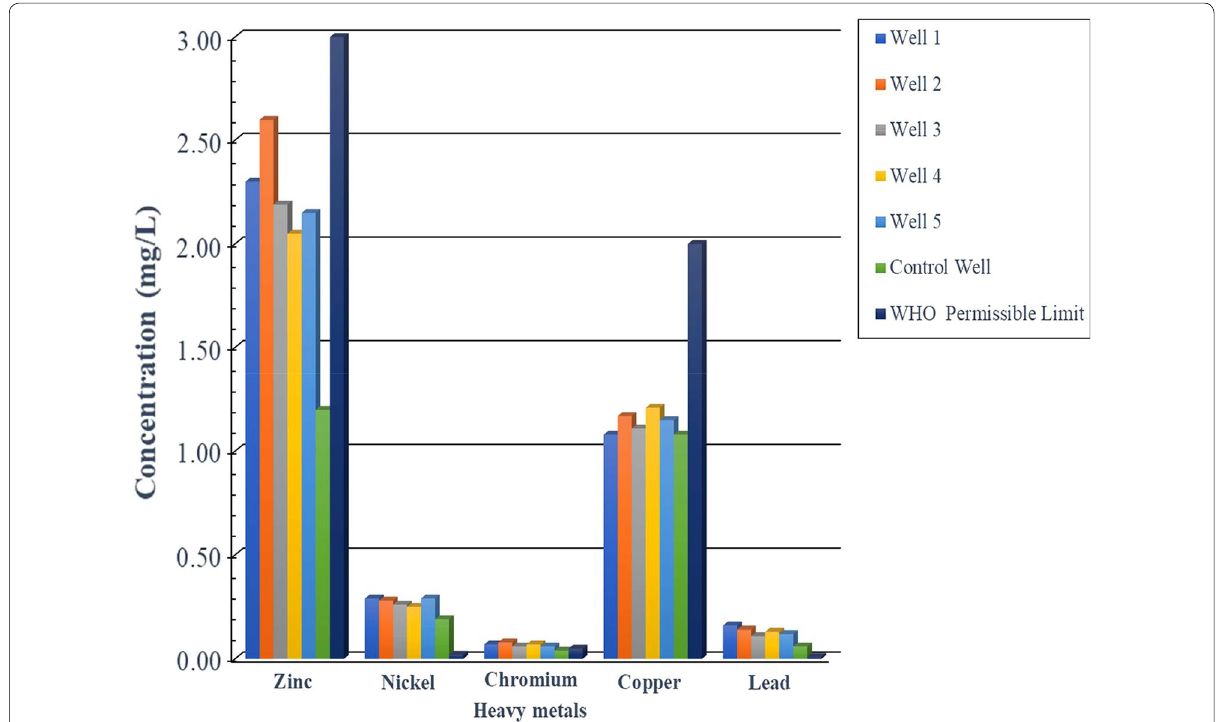
Fig. 3 Heavy metal analysis of water samples collected from the sampling